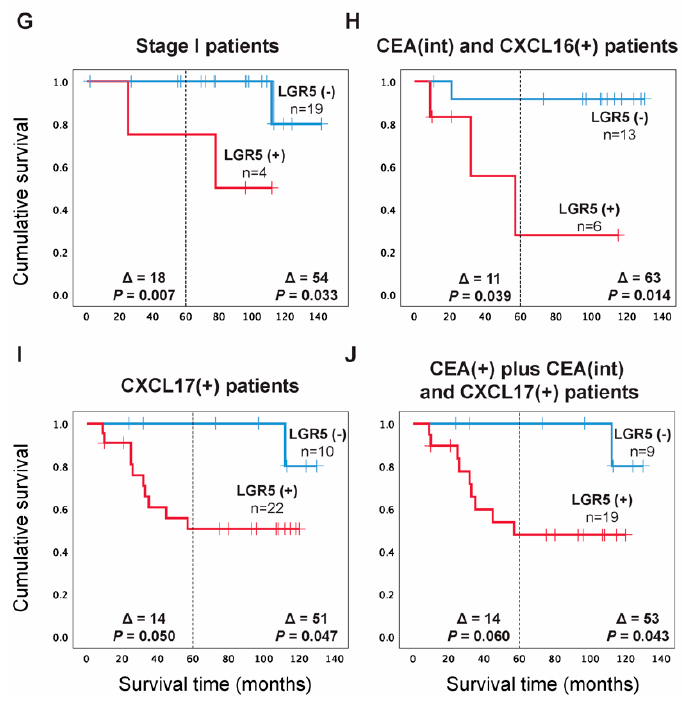
Figure 4. Kaplan-Meier cumulative survival curves for CC patients divided into two groups in ( A ) EpCAM(-) and EpCAM(+) according to the median of the expression level in the highest lymph nodes of the CC patients in TNM stages III and IV (0.07 mRNA copies/18S rRNA unit). ( C ) LGR5(-) and LGR5(+) according to the median of the expression level in lymph nodes of all CC patients in TNM stage IV (0.06 mRNA copies/18S rRNA unit). ( E ) LGR4(-) and LGR4(+) according to the 75th percentile of LGR4 mRNA expression values in all CC patients’ highest lymph nodes (2.558 mRNA copies/18S rRNA unit). In ( B , D , F ), the Kaplan-Meier cumulative survival curves for EpCAM, LGR5 and LGR4 patients are restricted to the CEA(+) plus CEA(int) subgroup of CC patients. In ( G – J ), the Kaplan-Meier cumulative survival curves for LGR5 patients are restricted to TNM stage I patients only ( G ), CEA(int) plus CXCL16(+) subgroups of patients ( H ), CXCL17(+) patients only ( I ) and CEA(+) plus CEA(int) plus CXCL17(+) patients subgroups ( J ). The patients were followed for 12 years. Differences in disease-free survival time after surgery between the two groups are given as a ∆ -value in months and statistical significance as p -values. n = number of patients in the respective